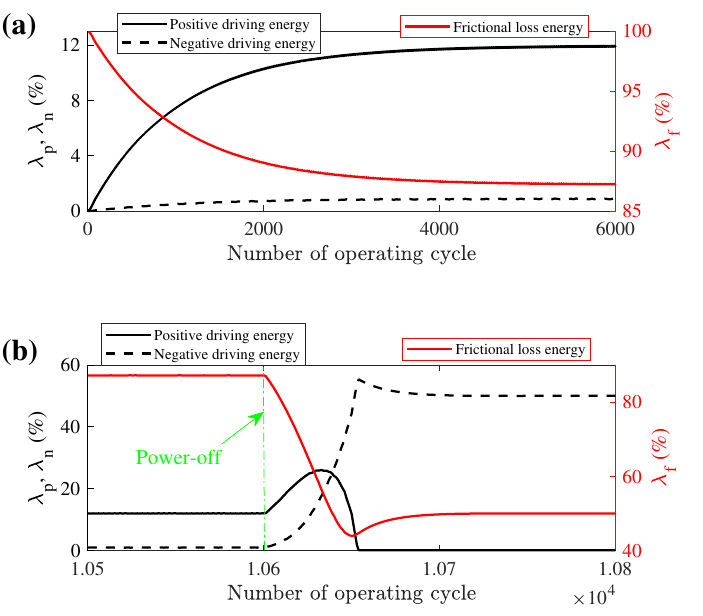
Figure 27. The transient energy transmission with the running cycle during: ( a ) ON transient state; ( b ) OFF transient